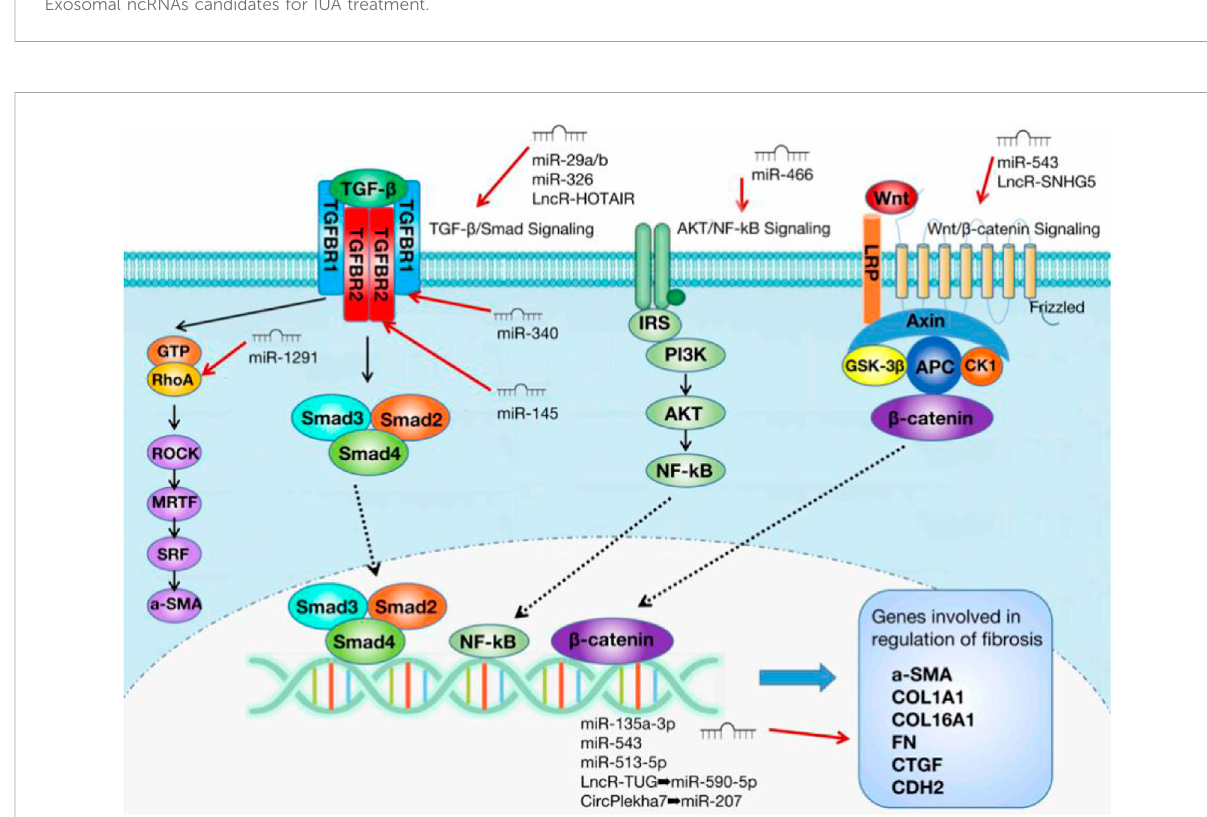
FIGURE 3 Three core signaling pathways of endometrial fi brosis involving